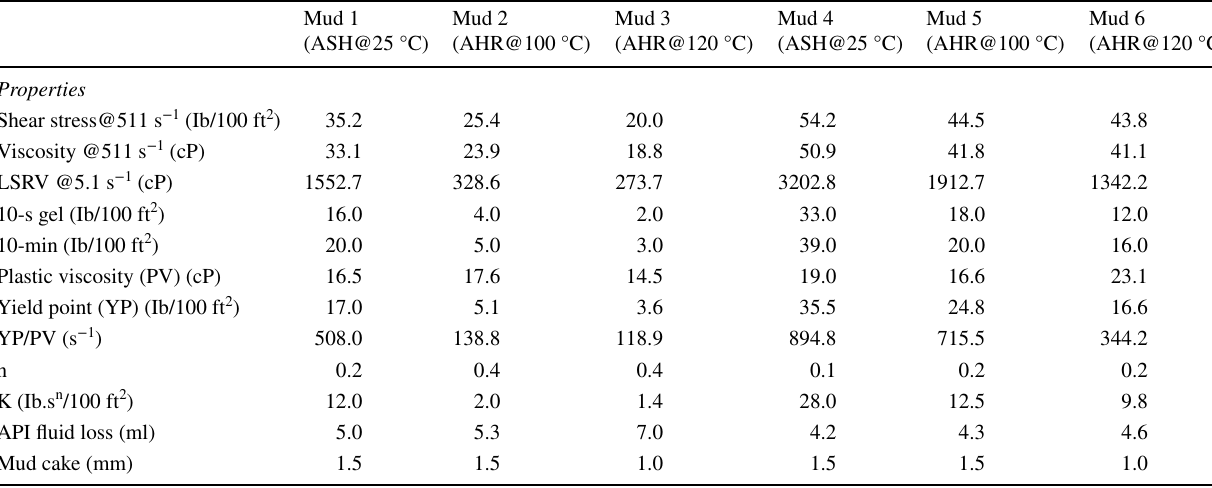
Table 3 Properties of the drilling muds prepared without